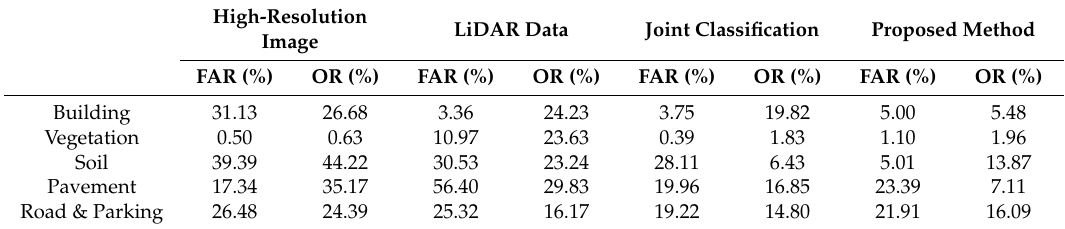
Table 7. False alarm rate (FAR) and omission rate (OR) of each class for the proposed method and the comparison methods. Bold numbers indicate the lowest rates of false alarms and omissions for each